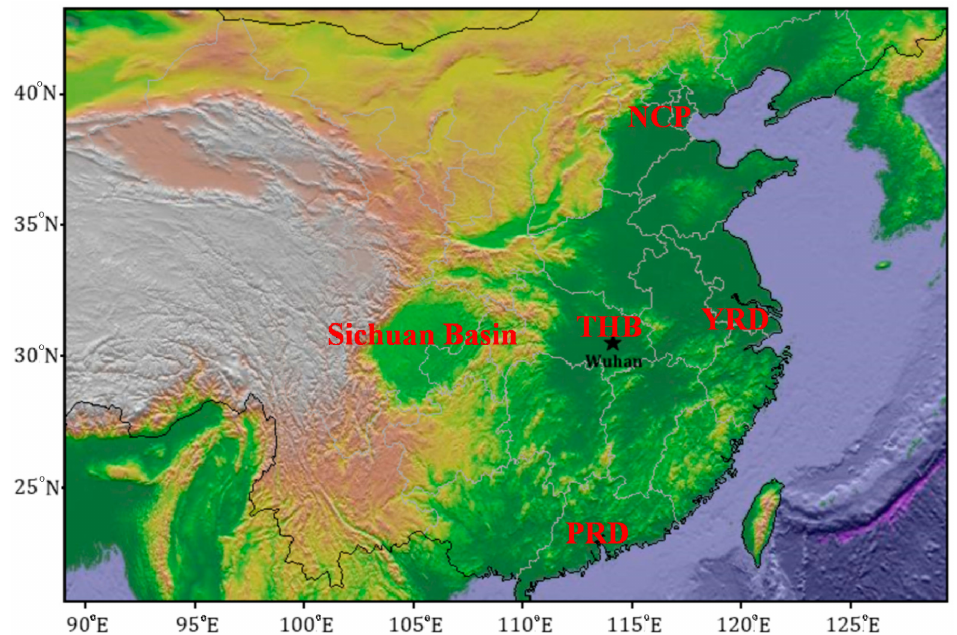
Figure 1. The geography map, NCP: North China Plain, THB: Twin-Hu Basin, YRD: Yangtze River Delta, PRD: Pearl River